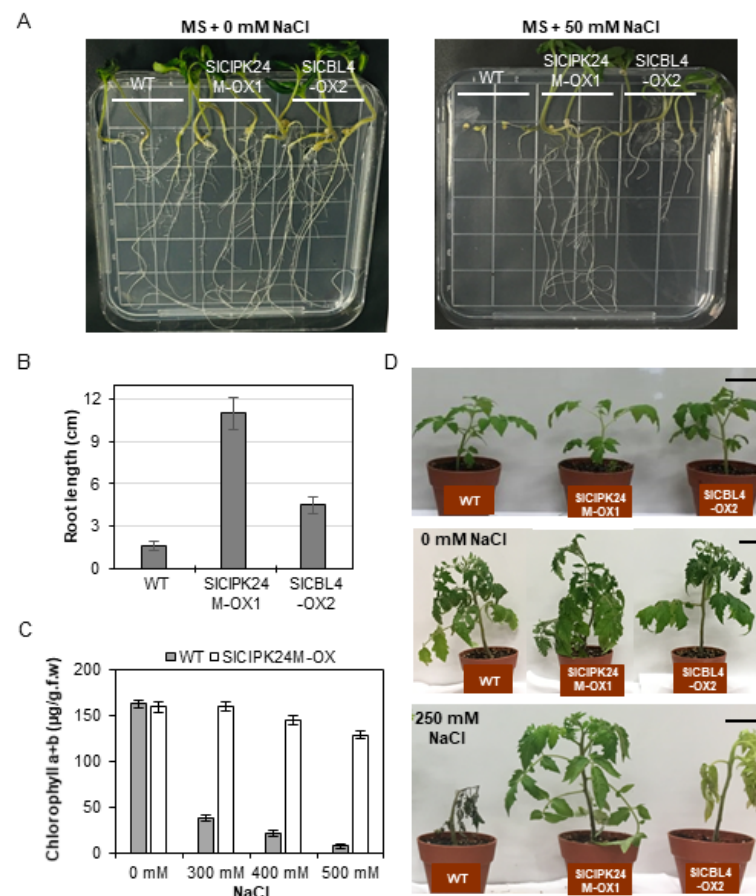
Figure 6. Phenotype analysis of transgenic tomato plants under salt stress. ( A ) Vertical growth assay. The indicated seeds were plated on MS agar media supplemented with 0 mM ( left panel) or 50 mM NaCl ( right panel), which were then placed vertically in the growth chamber. The photos were taken on the 13th day after transfer. ( B ) Root length of the seedlings from the experiment described in ( A ). The seedlings on 50 mM NaCl plates were measured. ( C ) Leaf chlorophyll contents. Ten-day-old soil-grown seedlings were treated with the different concentrations of NaCl solution for two days. For each condition, four plants were analyzed. Error bars denote standard deviation (SD) of three biological replicates. Values are significantly different (the Student’s t -test, p ≤ 0.05). ( D ) Salt stress tolerance of the mature transgenic plants. Three-week-old plants ( top ) were treated with 0 mM ( middle ) or 250 mM NaCl solution ( bottom ). The photos were taken on the 21st day after treatment. Scale bars, 5 cm. All the experiments were performed in three biological